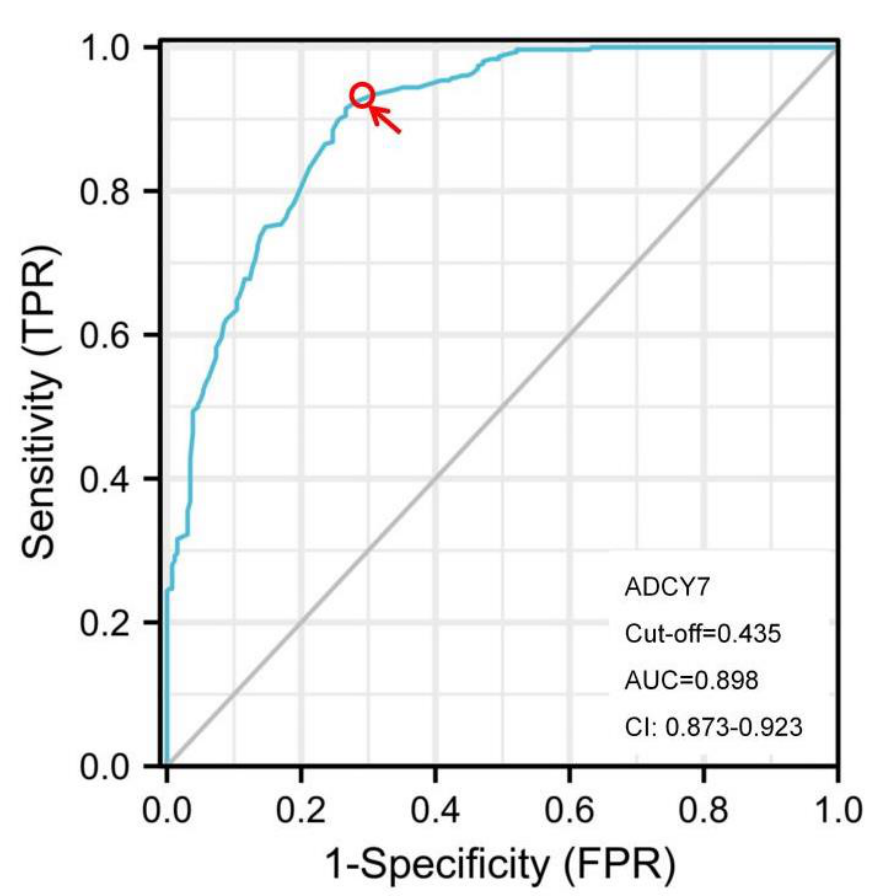
Figure 2. The ROC curve analysis of ADCY7 for identifying CIN2+ disease. Cut-off, the optimal ADCY7 expression used to predict CIN2+, was calculated according to the ROC curve. Abbreviations: CIN, cervical intraepithelial neoplasia; NILM, negative for intraepithelial lesion or malignancy; CC, cervical cancer; AUC, the area under the ROC curve; ROC, receiver operator character- istic. Table 2. Independent predictors for the detection of CIN2+ lesions.